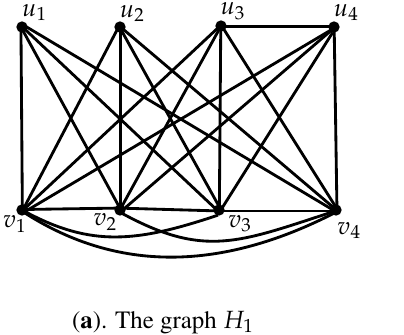
Figure 1. The graph H 1 and its N 2 -embedding.